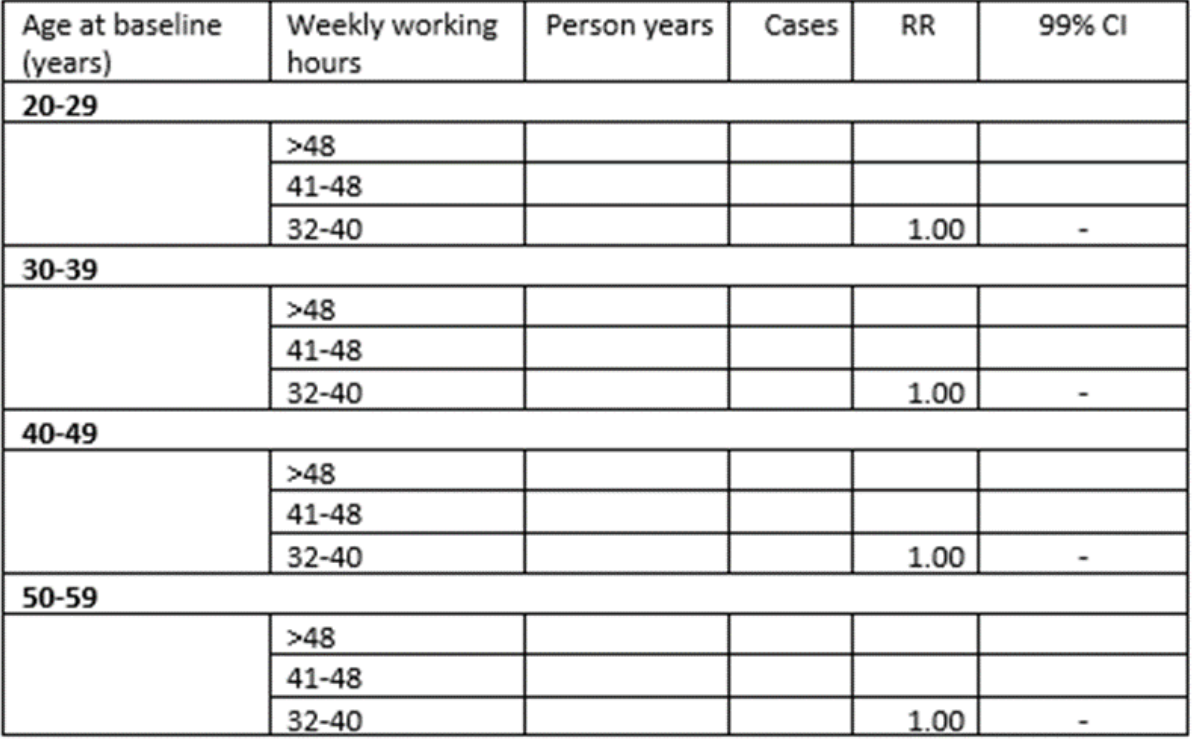
Figure 2. Dummy table: age group–specific rate ratios (RRs) with 99% CIs for incident use of psychotropic drugs as a function of weekly working hours among employees in Denmark in the calendar years